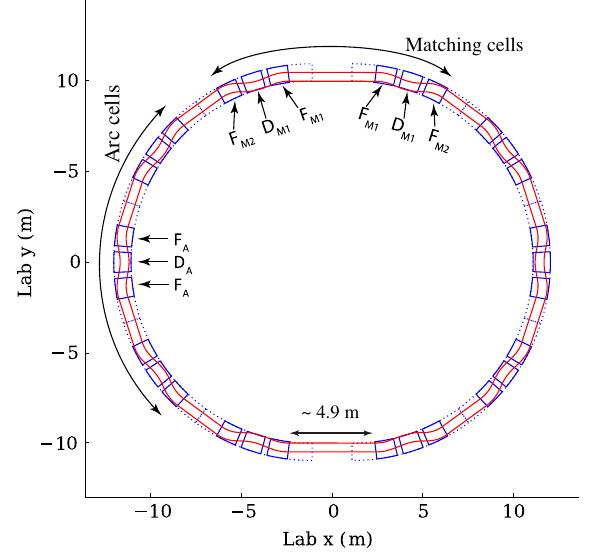
FIG. 15. A schematic of the NORMA racetrack lattice with L ¼ 2 . 0 m, showing the lowest (inner) and highest (outer) RT energy orbits in red. Magnets are outlined by solid blue lines and the cell boundaries as dashed blue lines. Note that the solid blue outlines indicate only the approximate radial positions and horizontal aperture of the magnets, however the sector width of each is accurate. The “ arc ” and “ matching ” type cells are indicated as well as the five families of associated magnets.